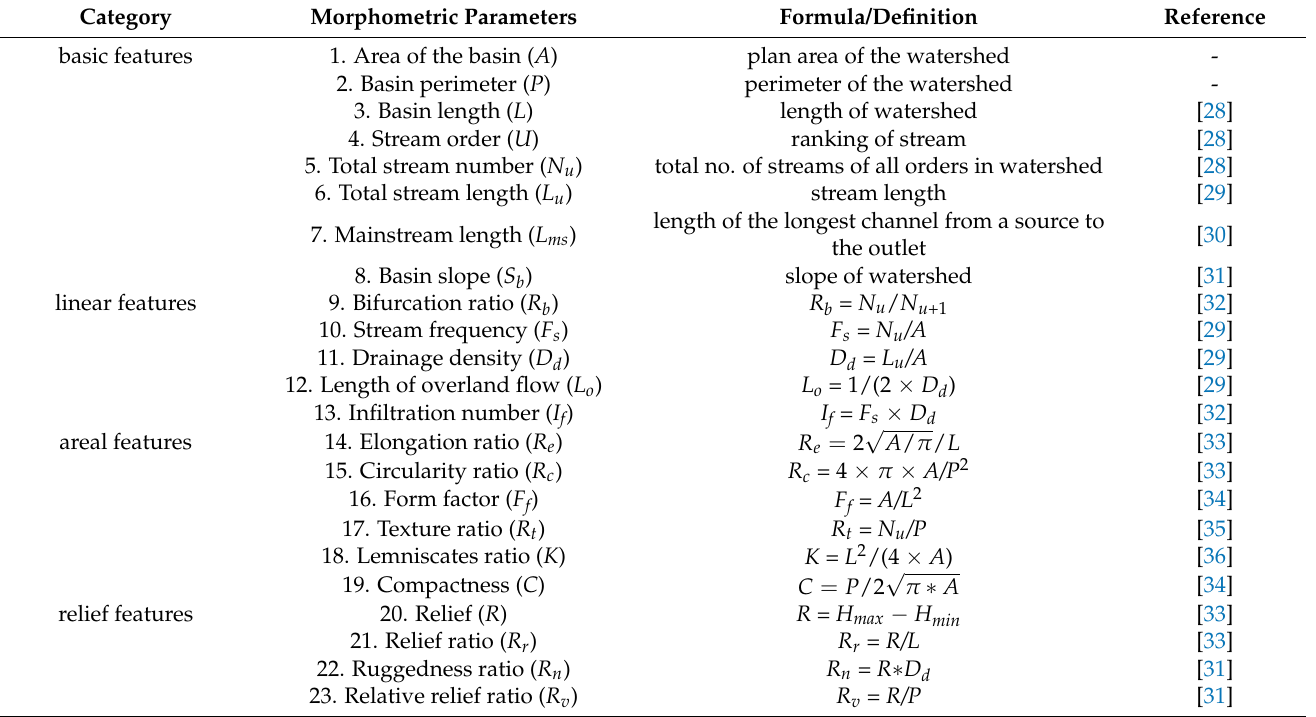
Table 1. Morphometric parameter and mathematical expression.